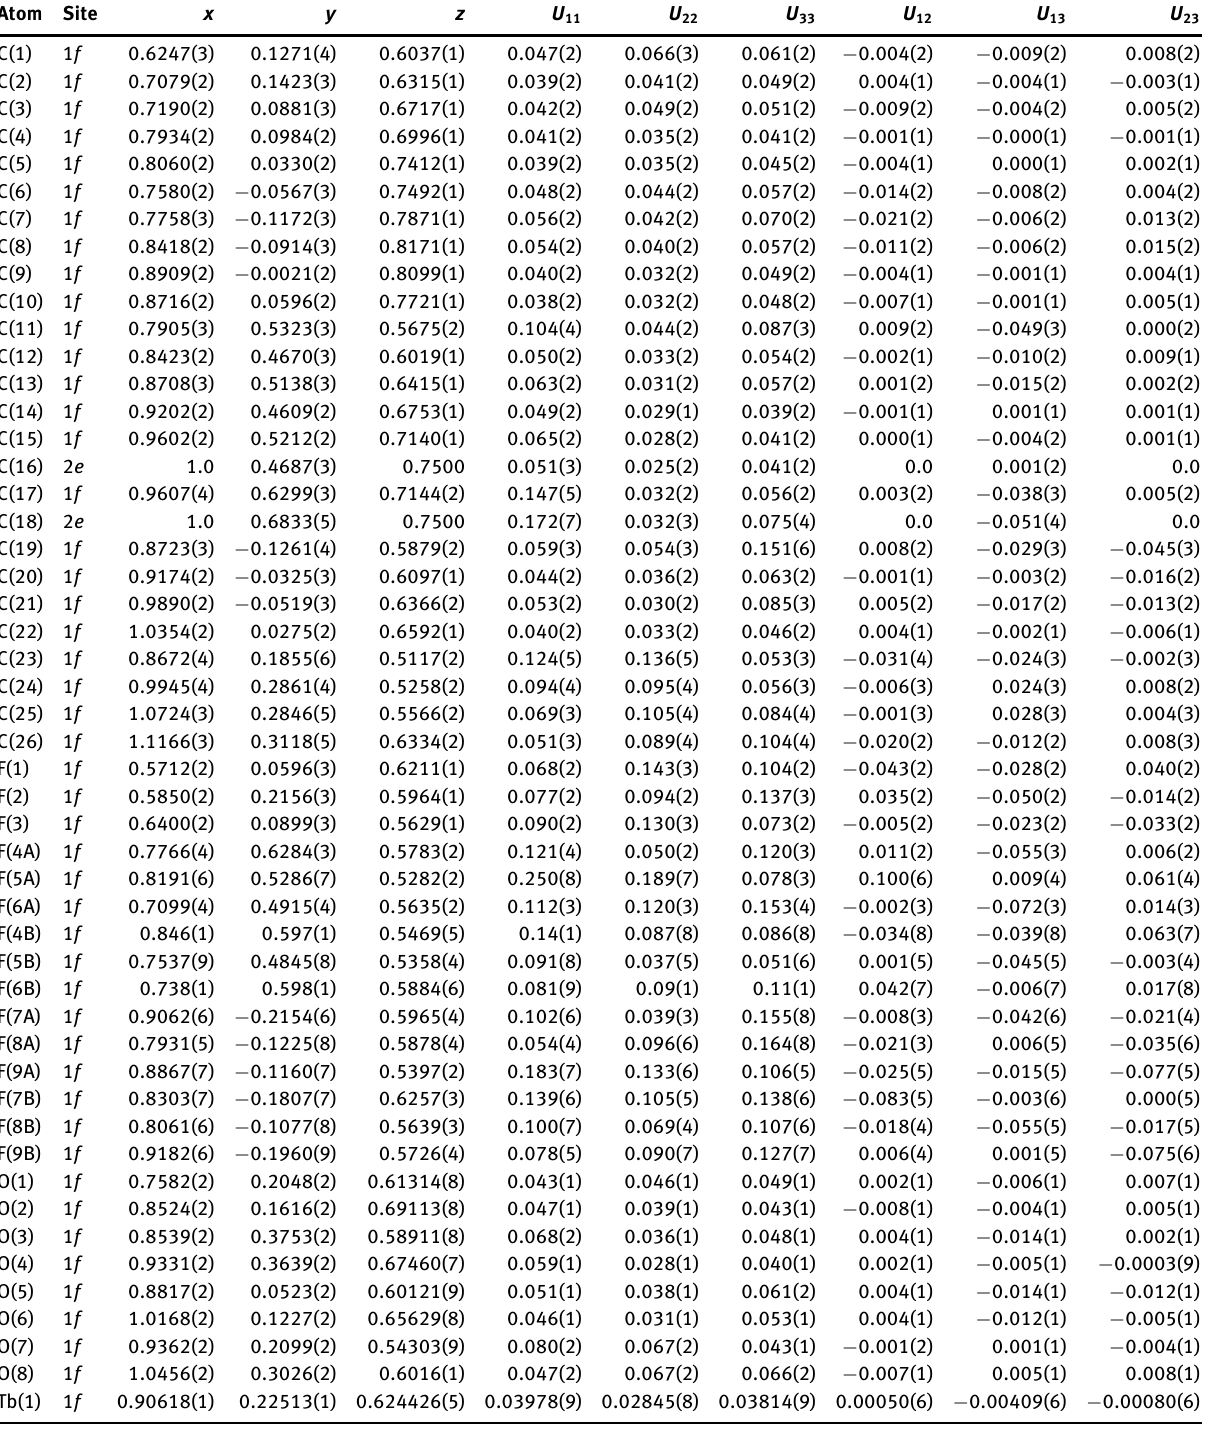
Table 3: Atomic displacement parameters (Å 2